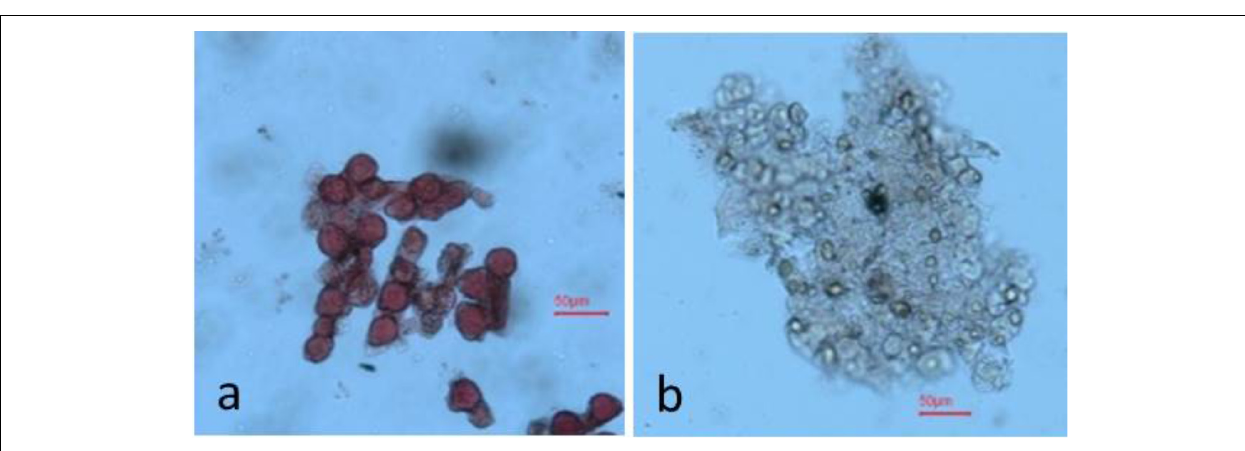
FIGURE 2 | Pollen of (a) male fertile (stained), and (b) male sterile (unstained)